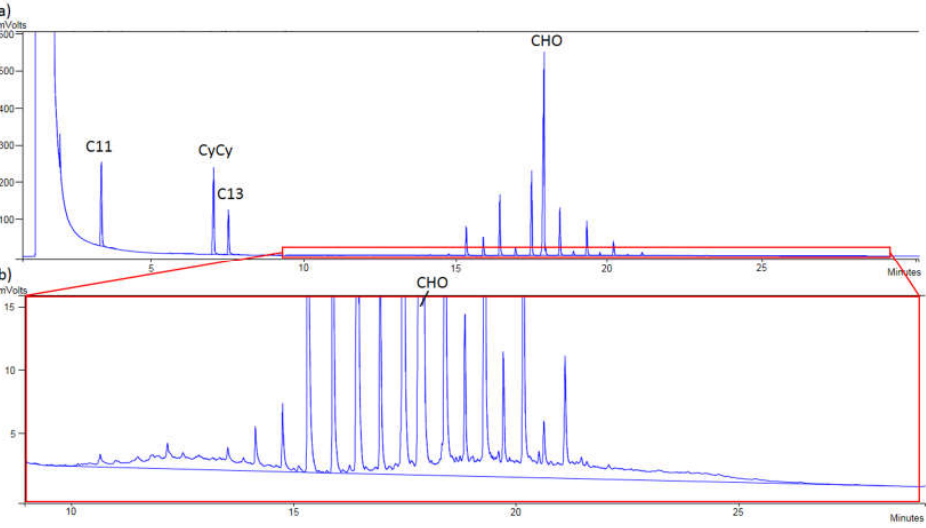
Figure 4. ( a ) Chromatogram of mineral oil aromatic hydrocarbons (MOAH) of the sample of refined olive oil 7 contaminated at 12.9 mg/kg (5B: pentylbenzene; 1-MN: 1-methylnaphthalene; 2-MN: 2-methylnaphthalene; TBB: 1,3,5-tri-tert-butylbenzene; PER: perylene). ( b ) Zoomed in from (a) (PER: perylene).